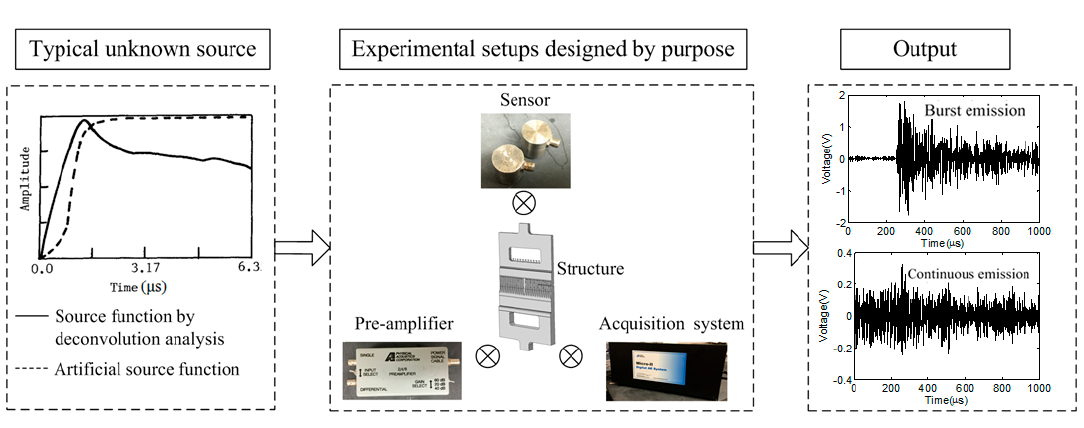
Figure 1. The measurement chain of AE signals.